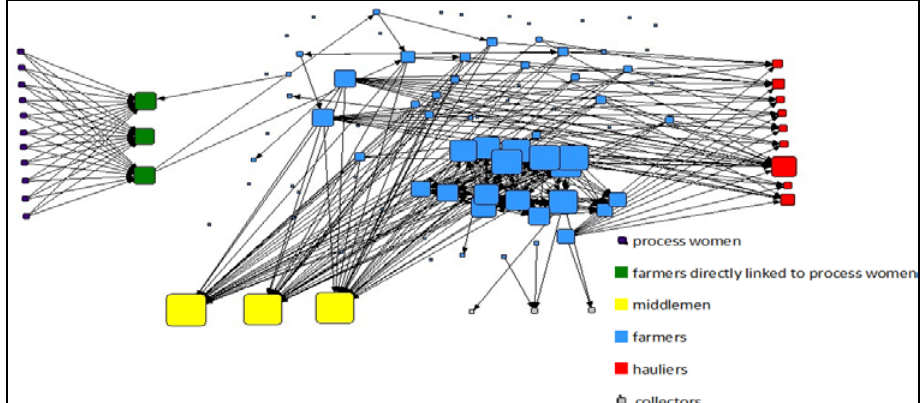
Figure 4. Relationships among actors in the peanut value chain of Thiel.